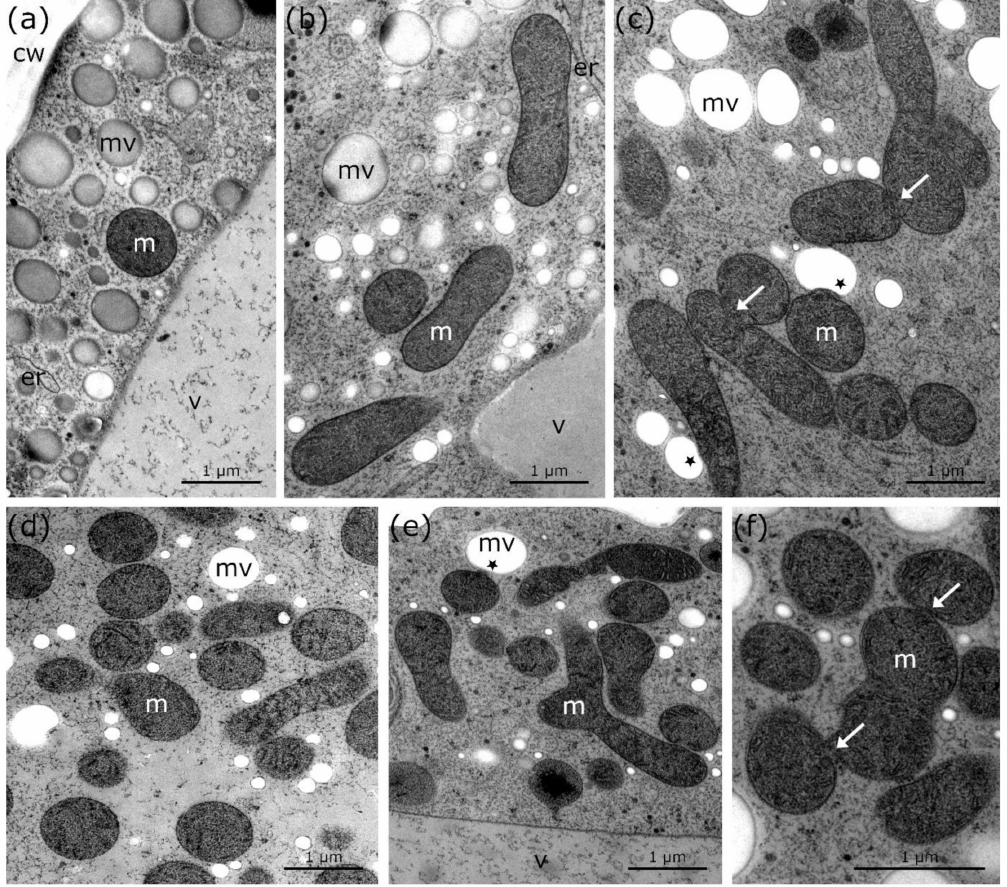
Figure 1. TEM micrographs of mitochondria in Micrasterias denticulata cells during cold stress in comparison to controls at + 20 ◦ C. ( a ) Control at + 20 ◦ C with round, solitary mitochondrion and single mucilage vesicles. ( b ) + 4 ◦ C, 24 h chilling treatment with elongated mitochondria and slightly bloated endoplasmic reticulum. ( c ) + 4 ◦ C, 3 weeks treatment with elongation, aggregation, and fusion of mitochondria (arrows) and protrusion of mitochondria into mucilage vesicles (asterisks). ( d ) − 2 ◦ C freezing (without ice) treatment—elongation and aggregation of mitochondria visible. ( e ) − 2 ◦ C, extracellularly frozen cell with elongation and aggregation of mitochondria and protrusion of mitochondria into mucilage vesicle (asterisk). ( f ) Higher magnification of − 2 ◦ C, extracellularly frozen cell shows attachment and fusion of outer mitochondrial membrane (arrows) as well as aggregation to mitochondrial network. m: mitochondria, mv: mucilage vesicles, v: vacuole, cw: cell wall, er: endoplasmic